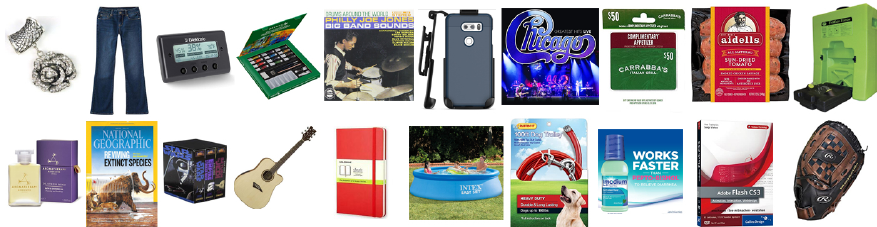
Figure 5. Examples of goods from different categories (Amazon